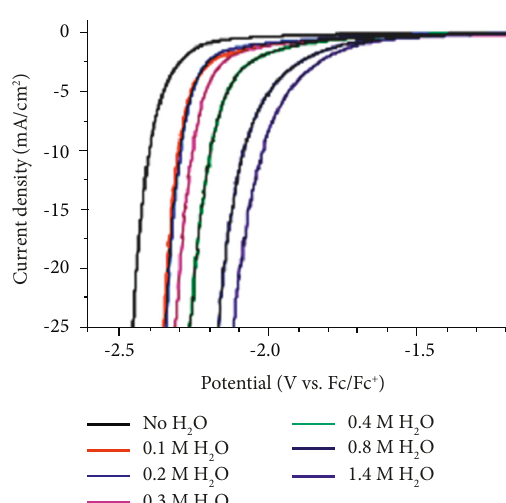
oxalate yield with decreasing temperature. Thus, at a CO concentration of 152 mmol · dm − 3 , the distribution of products is as follows: oxalate, 67%; CO, 25% and oxalate, 11%; CO, 89% at temperatures of 25 and − 20 ° C, respectively.